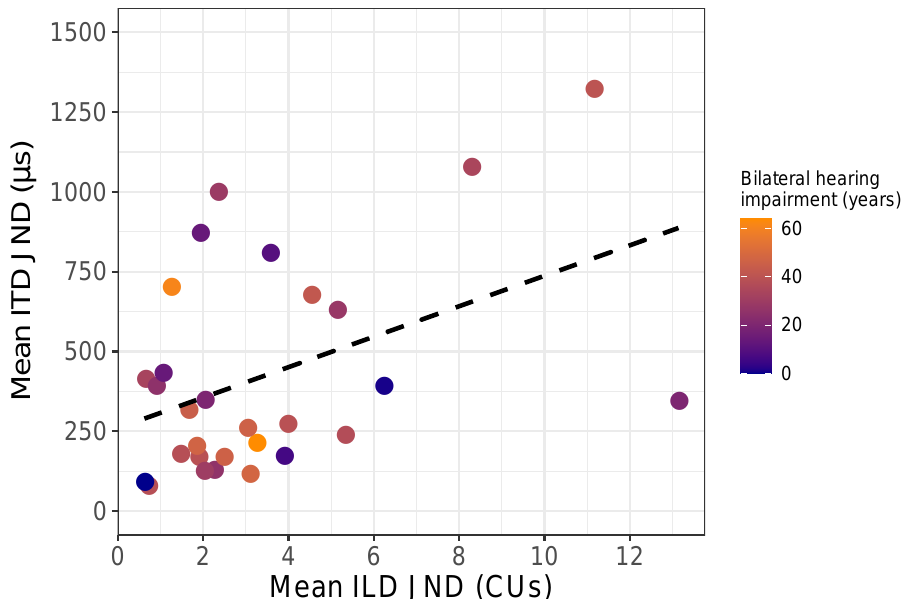
Figure 7. Comparison of ITD and ILD Just-noticeable di ff erences (JNDs) as a function of years of bilateral hearing impairment. Blue-colored symbols indicate fewer years of bilateral hearing impairment and orange-colored symbols indicate greater years of bilateral hearing